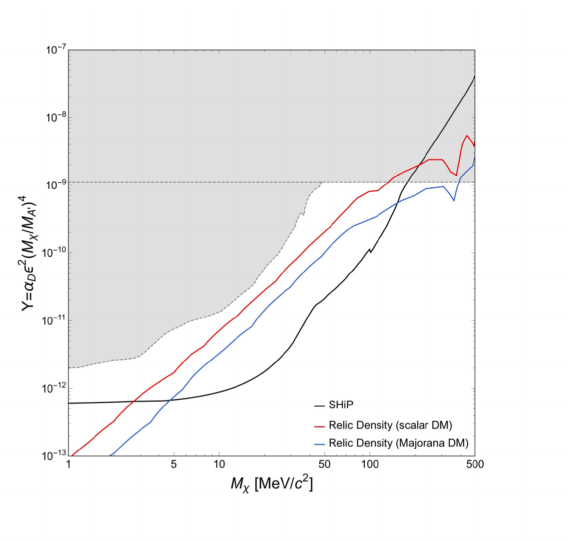
Figure 7. Sensitivity to the dark matter search.